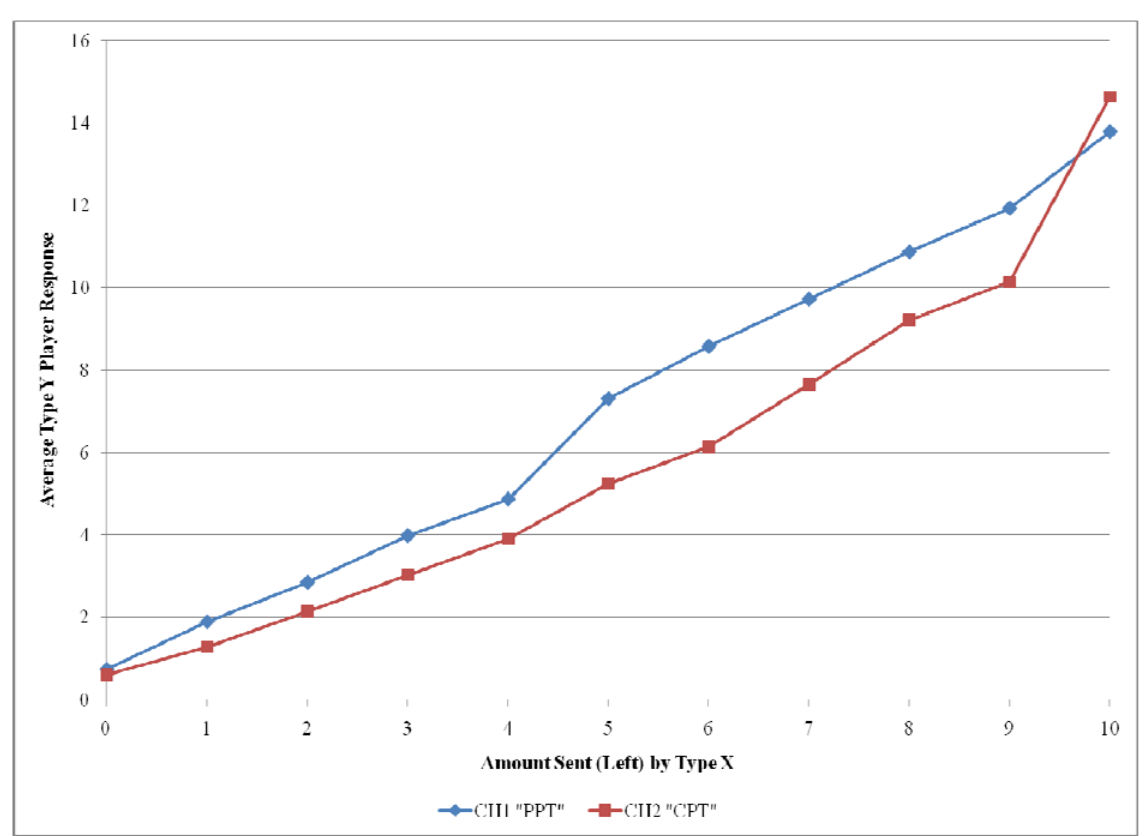
Figure 4. Comparison of average Type Y response data for CH1 and